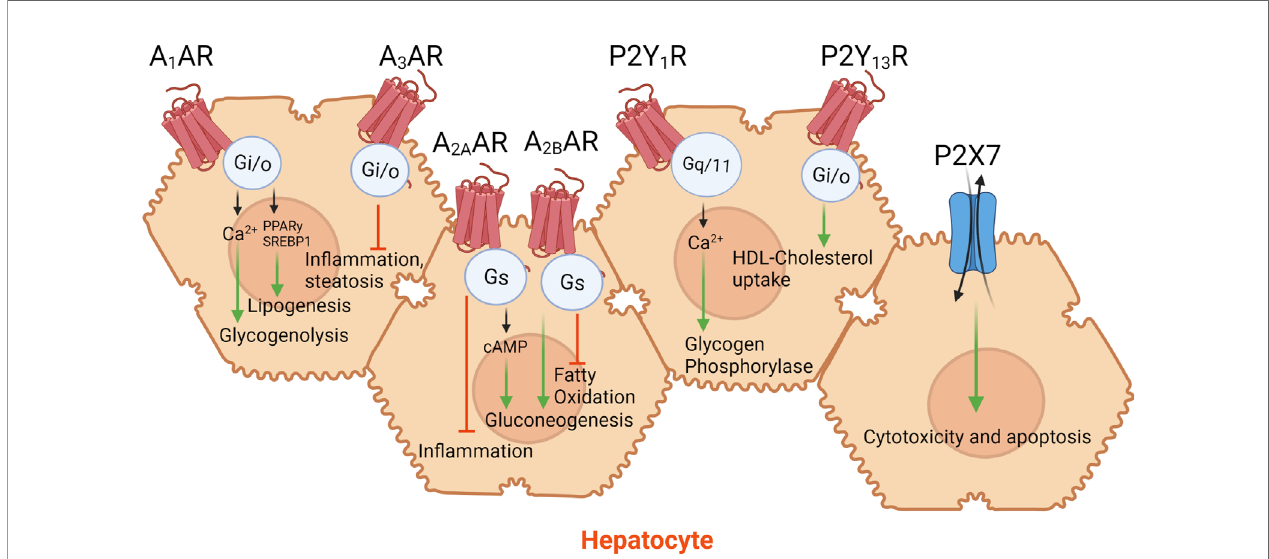
FIGURE 1 | Purinergic signaling in hepatocytes. Hepatocytes are parenchymal cells of the liver and are involved in maintaining whole-body glucose and lipid homeostasis. Hepatocytes express various purinergic receptors that play a key role in regulating glucose, lipid, cholesterol metabolism, and hepatocyte